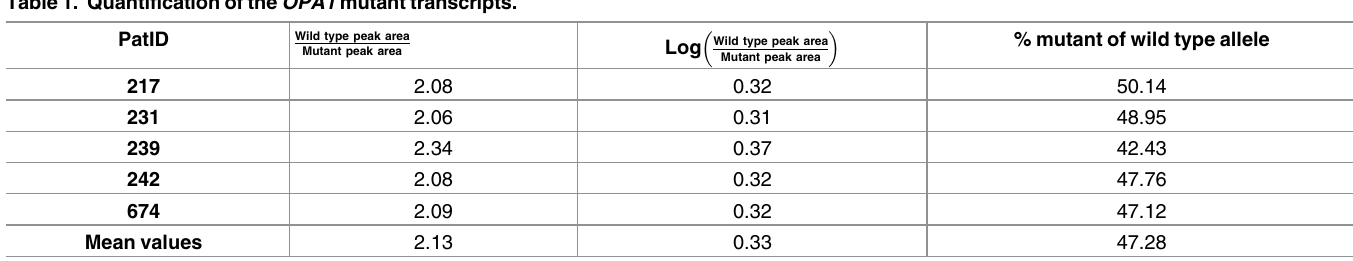
Table 1. Quantification of the OPA1 mutant transcripts. PatID Wild type peak area Mutant peak